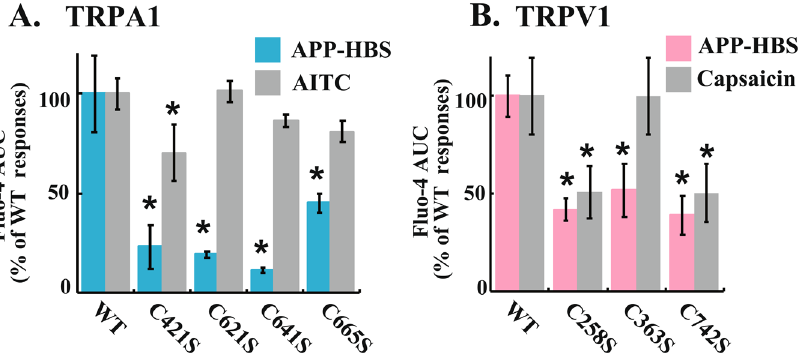
Figure 4. Mutational analysis of TRPA1 and TRPV1 channels for the indirect APP-responsive [Ca 2 + ] i transients. ( A , B ) Quantification of the indirect APP-responsive [Ca 2 + ] i transients as well as the agonist- responsive [Ca 2 + ] i transients ( grey bars ) in C2C12 myoblasts expressing either TRPA1/its mutants ( blue bars ) or TRPV1/its mutants ( pink bars ) from 3 independent experiments. APP-HBS was applied at approximately 100 sec., followed by Fluo-4 monitoring for approximately for 10 min as described in Materials and Methods. AUC was evaluated from 100–500 sec. and the results are expressed as a percentage of the data obtained from C2C12 cells expressing wild-type channels. Transfected cells were identified by TMR-conjugated HaloTag- ligand staining after evaluation of [Ca 2 + ] i responses by Fluo-4 fluorescence. For each experiment, more than 10 transfected cells (TMR-positive cells) from each glass-bottom dish were measured. Statistical significance was determined by applying the Dunnett’s multiple comparison versus the control (WT). The effects of mutations are indicated by * ( P <